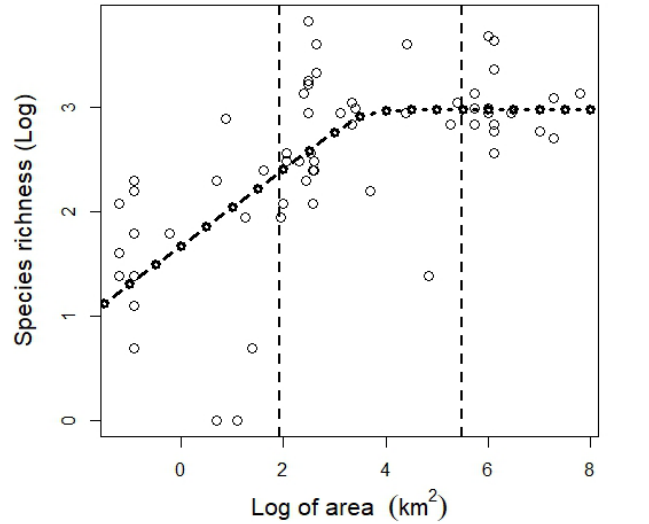
Figure 5. Linear piecewise model with hyperbolic smooth transition fitted to describe total richness of microcrustaceans (copepods + cladocerans) in function of the reservoir